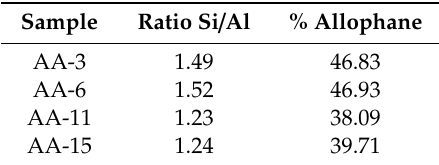
Table 15. Si / Al ratio of activated